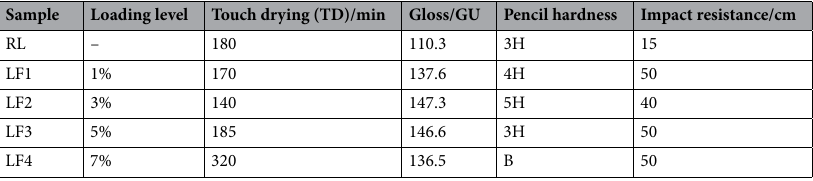
Table 1. The basic performance of RL and LF.